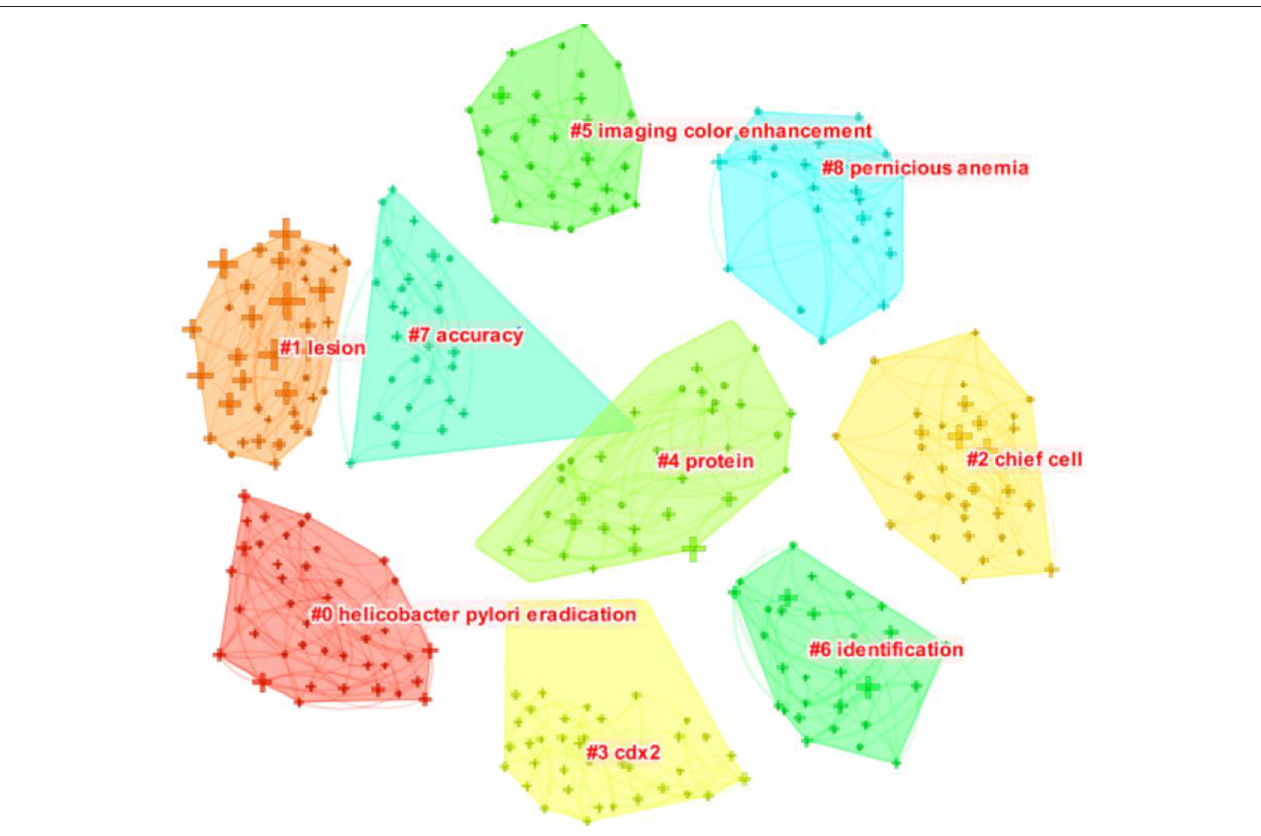
FIGURE 8 | Co-occurrence map of AG research keyword cluster